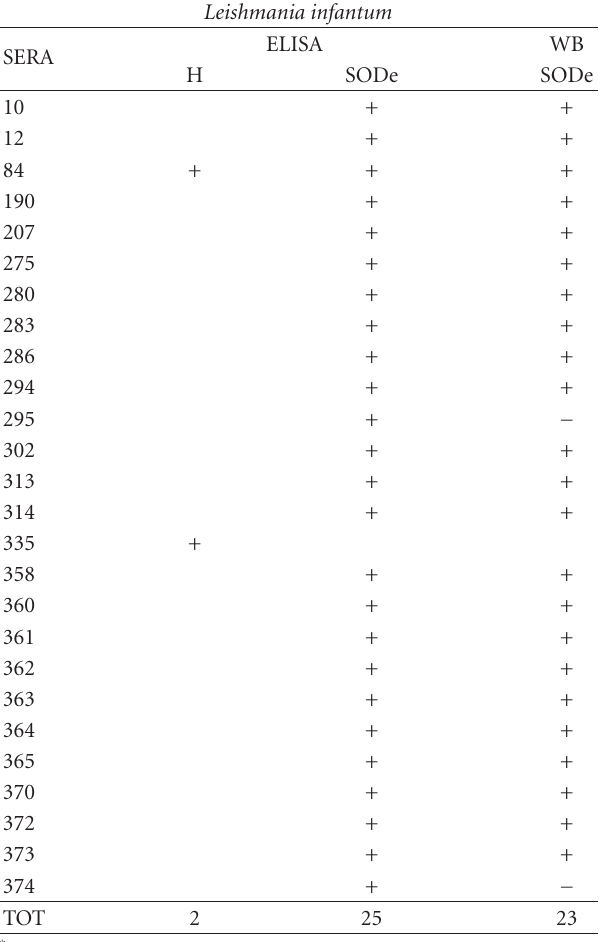
Table 3: The relationship of positive sera of dogs from the Peninsula of Yucatan (Mexico) with Trypanosomatids by ELISA and Western blot analysis against di ff erent antigen fractions of Leishmania infantum